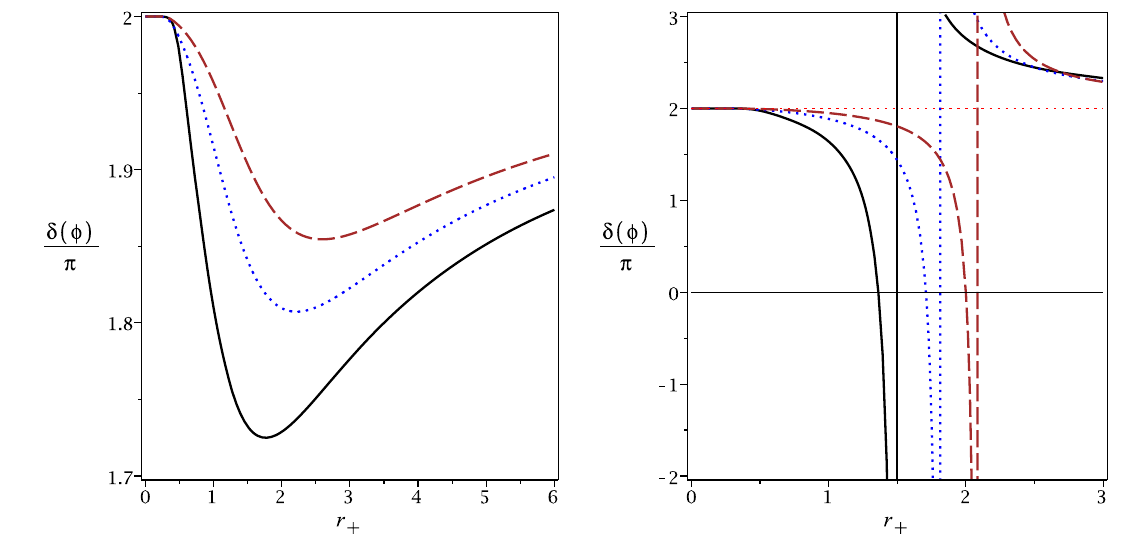
Fig. 4 PMI solutions: δ ( φ ) versus r + for q = 0 . 1, c = c 1 = c 2 = c 3 = c 4 = m = l = 1, d = 5, s = 0 . 8 (continuous line), s = 1 (dotted line) and s = 1 . 1 (dashed line). Left diagram: (cid:3) = − 1; right diagram: (cid:3) = 1